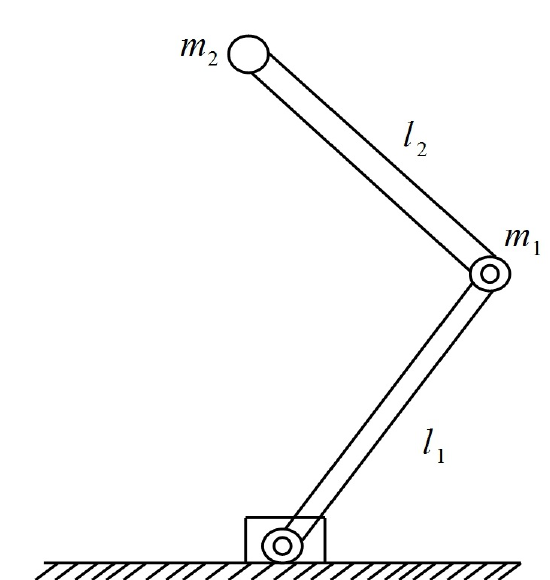
Figure 3. Two-link